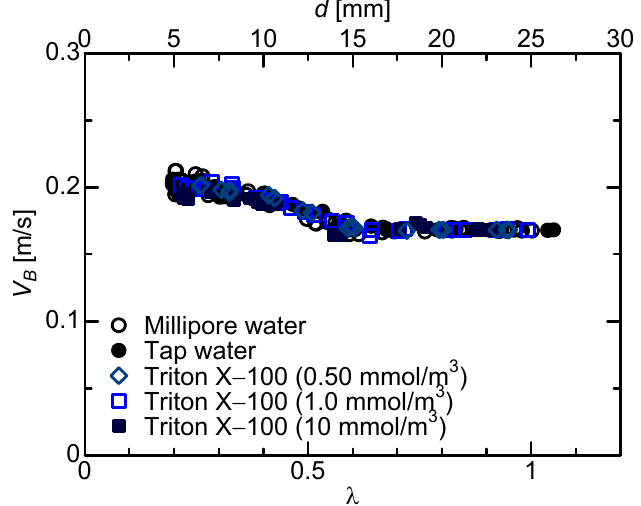
Fig. 7 Comparison of bubble rising velocities in stagnant